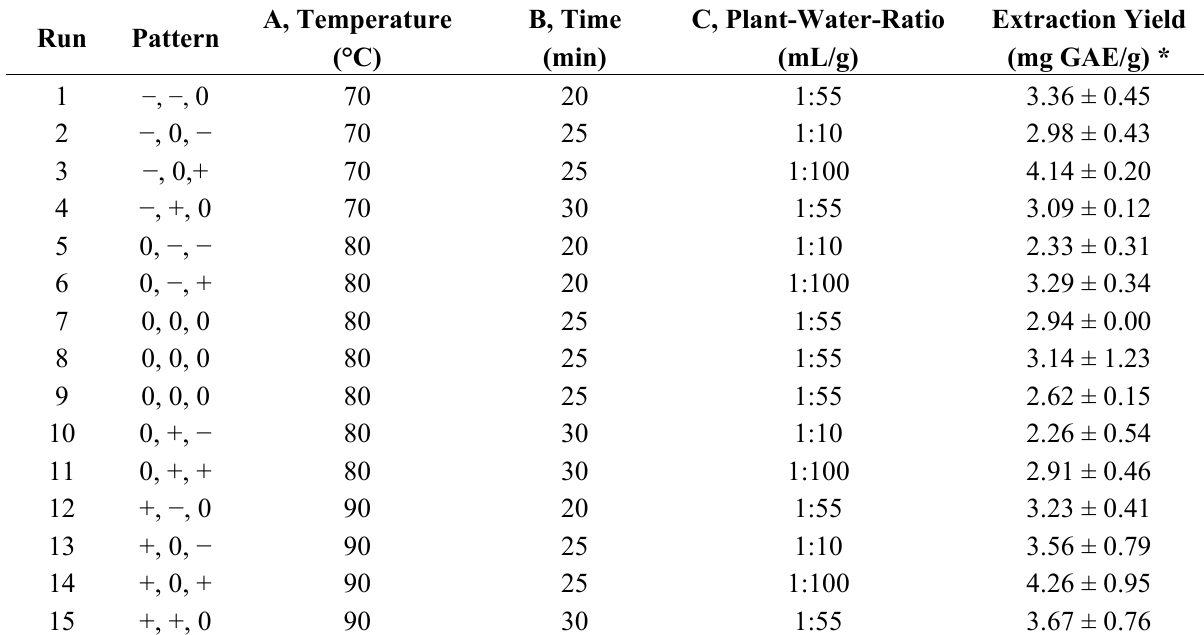
Table 1. Box-Behnken design and observed responses on total phenolic content (TPC) extraction yield of E. tirucalli